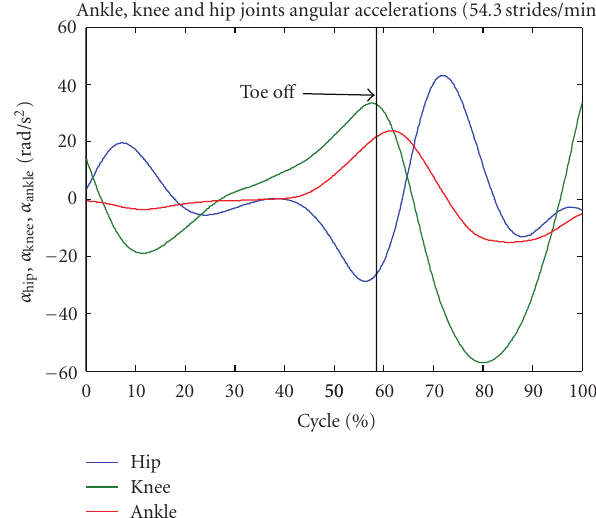
Figure 9: The robot joint trajectories based on a human walking cycle (positive angles denote flexion/dorsiflexion).